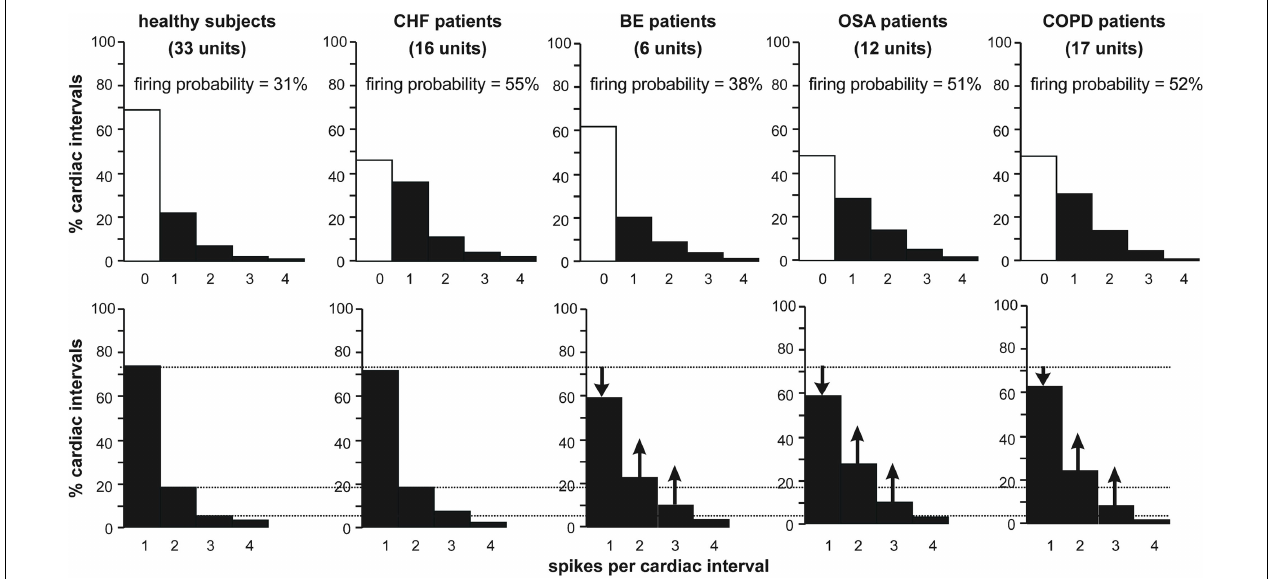
Ashley et al., 2010). The histograms showing pooled data on the percentage of cardiac intervals in which units were quiescent, fired a single spike or 2, 3, or 4 spikes. In the top panel, all cardiac intervals have been included: the open columns represent those cardiac intervals in which the neurons were silent. The lower panels show data in which only those cardiac intervals were included in which a unit was active.